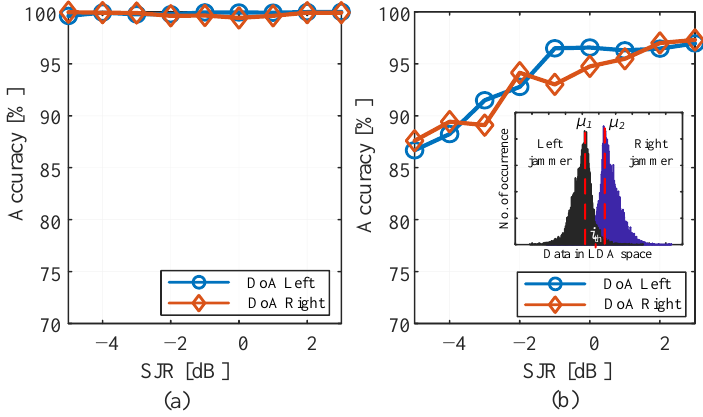
Figure 9. Jammer DoA identification using ( a ) CNN-based and ( b ) LDA-based